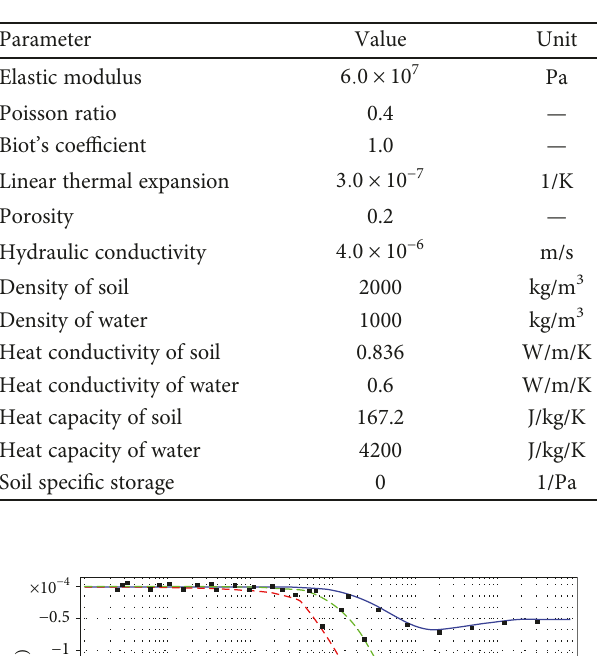
Table 3: Material parameters for the thermal consolidation problem.